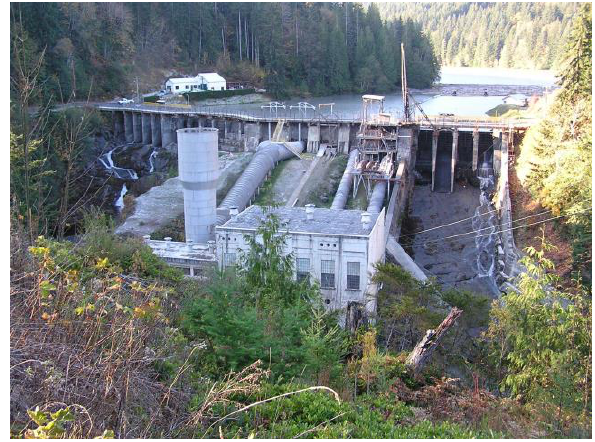
Figure 3. Elwha Dam before removal (Ward, 2005)